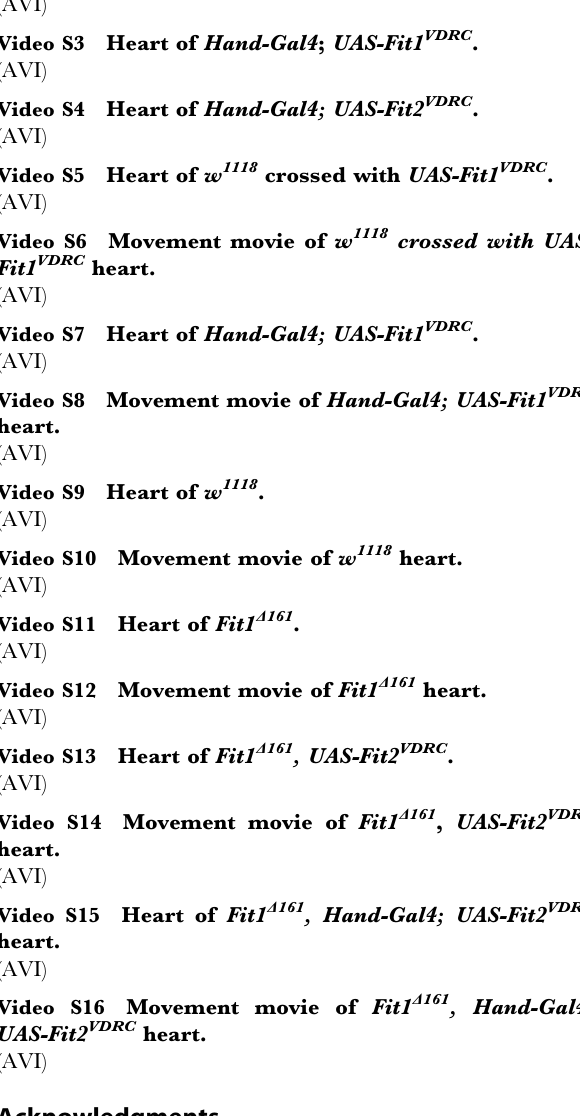
Figure S1 The Kindlin-2 FERM F3 subdomain, impor- tant for integrin-binding, is highly conserved in Dro- sophila Fermitins. Figure S2 The Fit1 VDRC RNAi targets both Fit1 and Fit2 gene expression in the Drosophila heart. (DOCX) Video S1 Heart of w 1118 control. Note: All videos show a representative 10 second sequence of the beating heart or movement movie derived from the beating heart. Videos S1 to S4, correspond to the data presented in Figure 3; videos S5 to S8 correspond to the data presented in Figure 4, and videos S9 to S16 correspond to the data in Figure